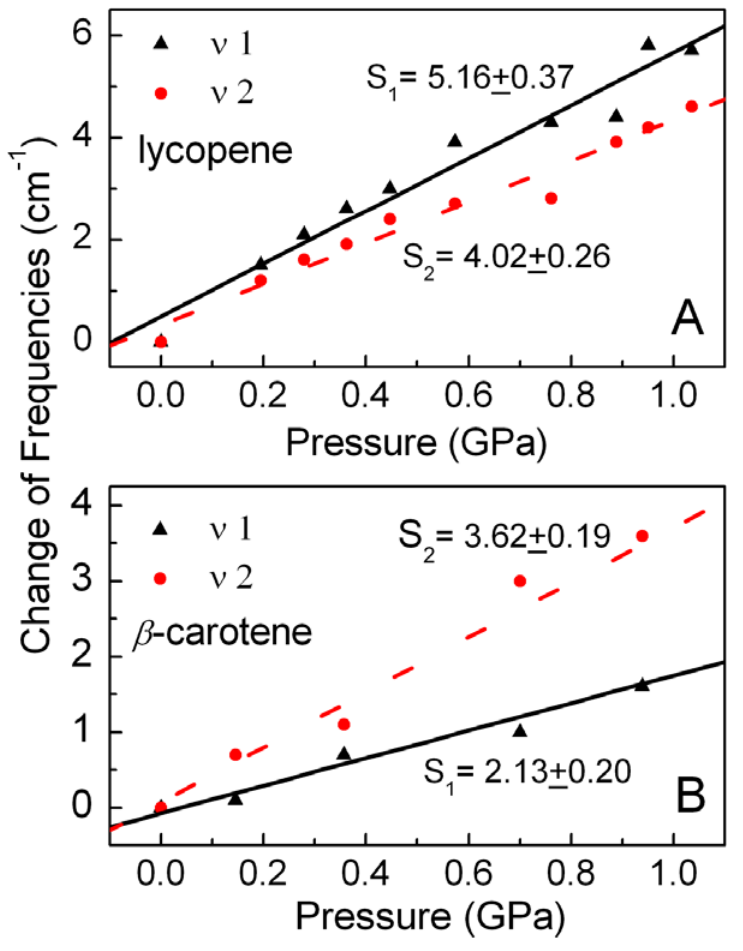
Figure 3. Effect of pressure on Raman frequencies of (A) lycopene and (B) β - carotene in n -hexane. The changes in the Raman frequencies relative to ambient pressure are shown for the ν ( (cid:99) ) and ν ( (cid:121) ) bands. The slopes (S) obtained from liner fitting are also presented 1 2 with frequency in cm − 1 and pressure in